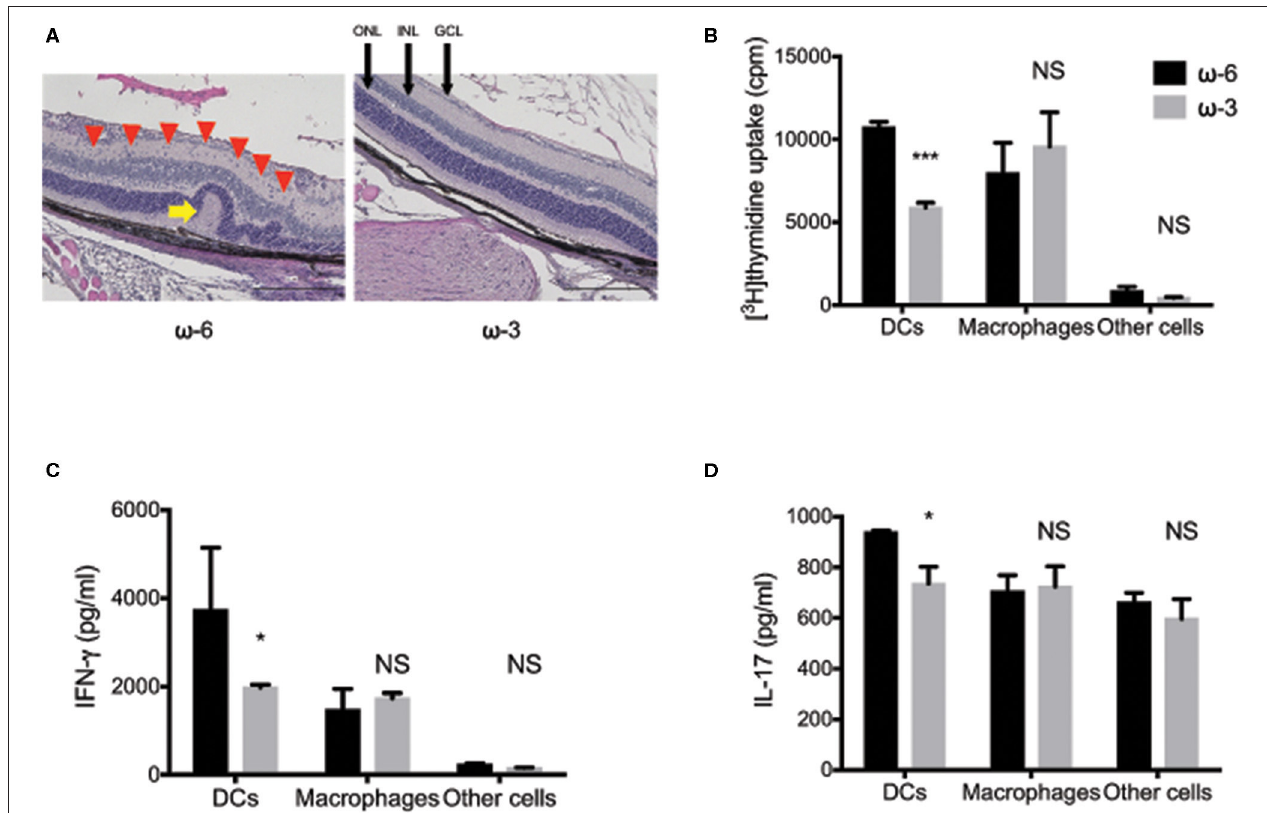
FIGURE 1 | The effects of ω -3 long chain polyunsaturated fatty acids in experimental autoimmune uveitis model mice. (A) Hematoxylin-eosin staining of retinal sections at 17 days after disease induction in experimental autoimmune uveitis (EAU) mice maintained on a diet enriched with ω -3 or ω -6 long-chain polyunsaturated fatty acids (LCPUFAs). A red arrowhead indicate inflammatory cells in the retina. A yellow arrow indicates a retinal fold. GCL, ganglion cell layer; INL, inner nuclear layer; ONL, outer nuclear layer. Scale bars, 200 µ m. (B–D) The proliferation of T cells, as assessed by the measurement of [ 3 H]thymidine incorporation (B) , and by the production of interferon- γ (C) , and interleukin-17 (D) in co-cultures of CD4 + T cells from EAU mice and the indicated antigen presenting cell fractions from mice fed with ω -3 or ω -6 LCPUFAs. Data are expressed as the means + the standard error of the mean (SEM). * P < 0.05, *** P < 0.001; NS, not significant vs. the corresponding value for the ω -6 LCPUFA diet (i.e., Sidak’s multiple comparison test). The figure is reproduced from (77) with